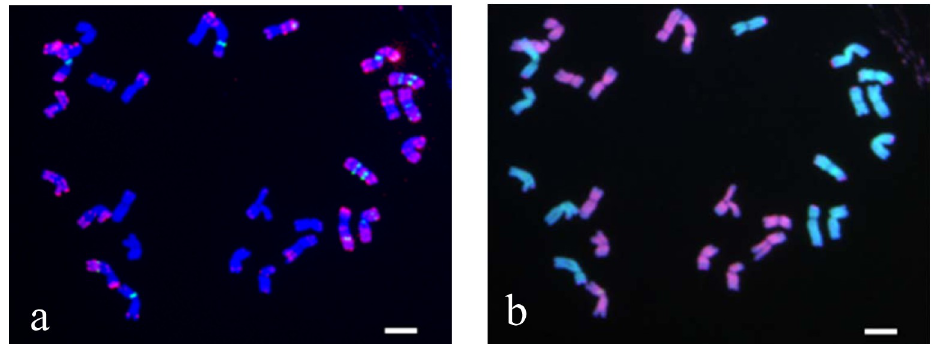
Fig 1. Sequential FISH and GISH patterns of Elymus sibiricus ‘Nongmu’. a: FISH pattern probed with ( AAG ) 10 (green) and Oligo-pAs1 (red); b: Sequential GISH pattern probed with Hordeum bogdanii (green) and Pseudoroegneria stipifolia (red). Scale bar = 10 μ